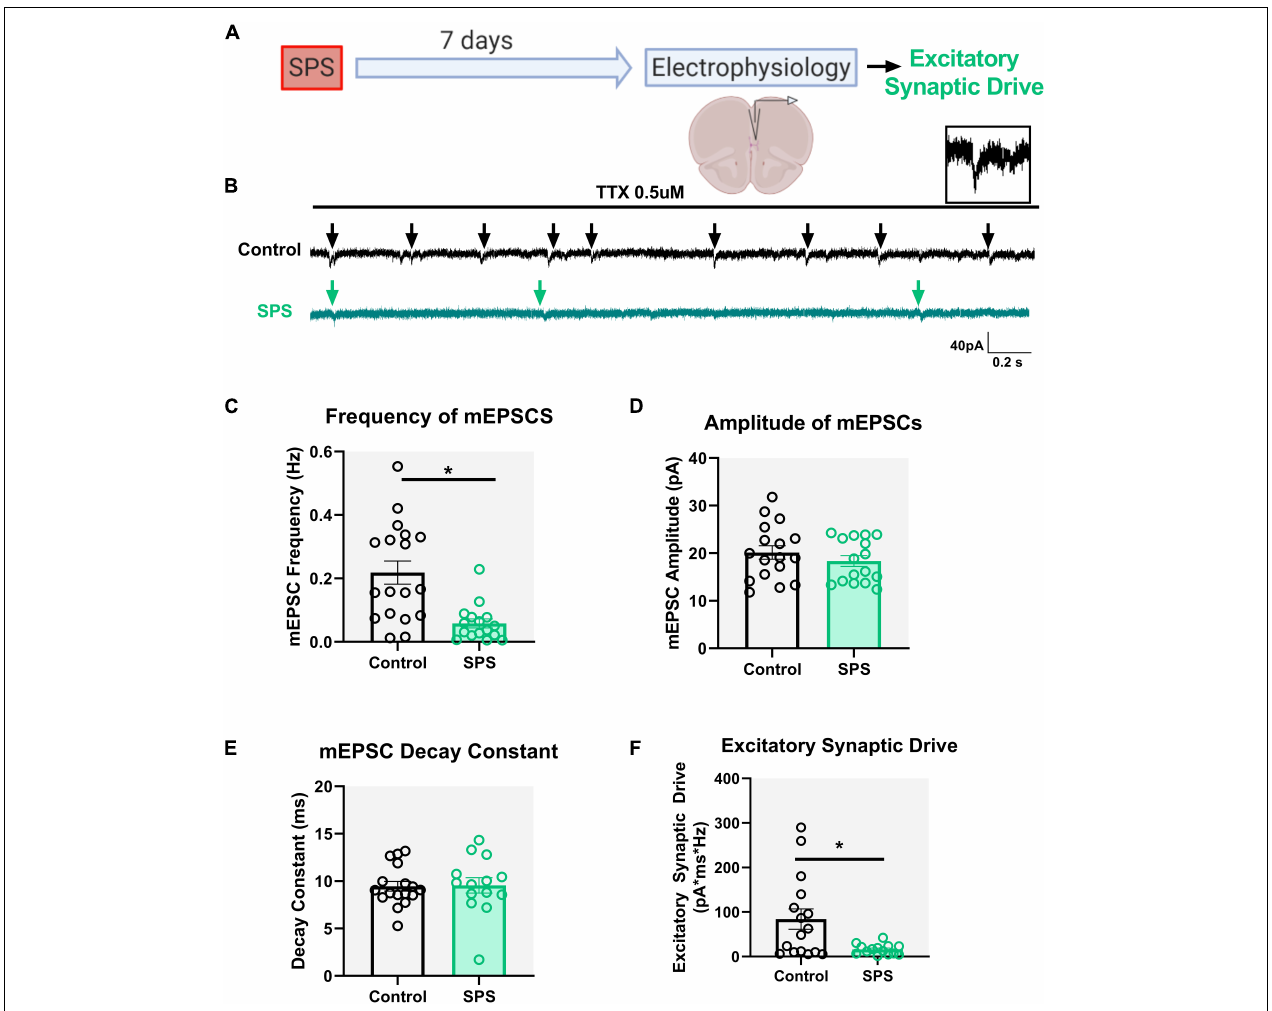
FIGURE 2 | SPS decreases spontaneous glutamatergic drive onto IL pyramidal neurons. Schematic of the experimental timeline (A) . Electrophysiological recordings in voltage clamp mode from the IL mPFC were conducted in male rats 7 days post SPS. Representative voltage clamp mEPSC traces of control (black) and SPS (green) groups are shown in (B) . Arrows indicate mEPSC events. Scale bars: 40 pA, 0.2 s. Magnified image of a single mEPSC event is shown on top right (B) . SPS decreases frequency of mEPSCs (C) [ t (32) = 3.9, p < 0.01]. SPS has no effect on mEPSC amplitude (D) [ t (32) = 0.9, p = 0.3] or mEPSC decay rate (E) [ t (29) = 0.1, p = 0.9]. SPS significantly decreases excitatory synaptic drive (F) (Mann–Whitney U = 62, p < 0.05). Data presented as Mean ± SEM. * indicates p < 0.05. n = 14–18 cells from three rats in each